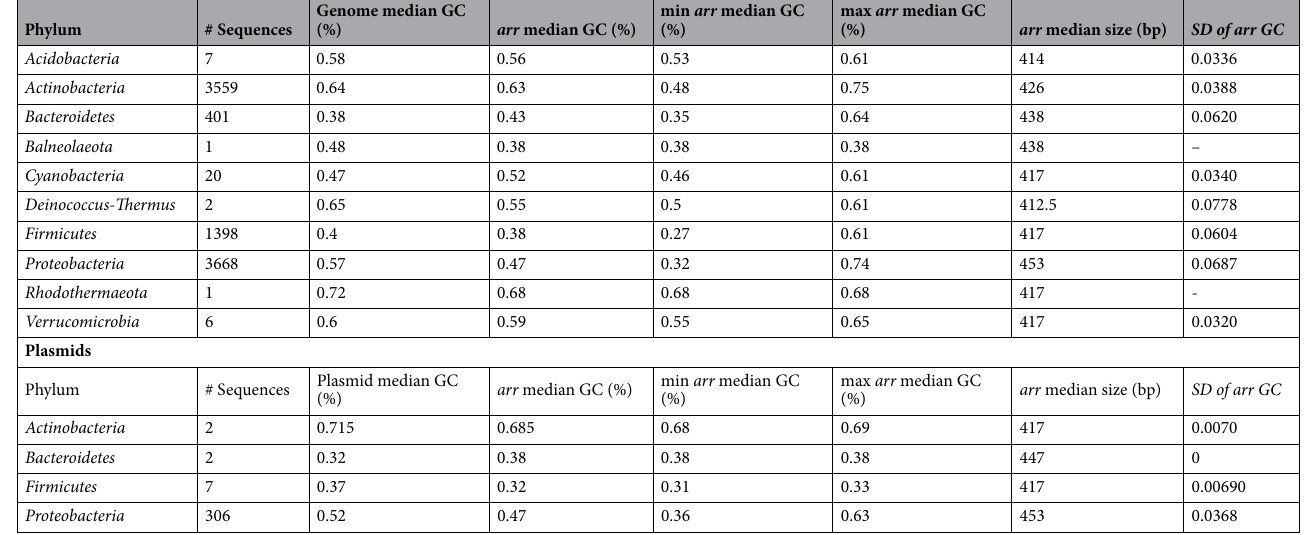
Table 1. Distribution of Arr sequences and median GC content of the arr and genome of their hosts. * SD standard derivation.